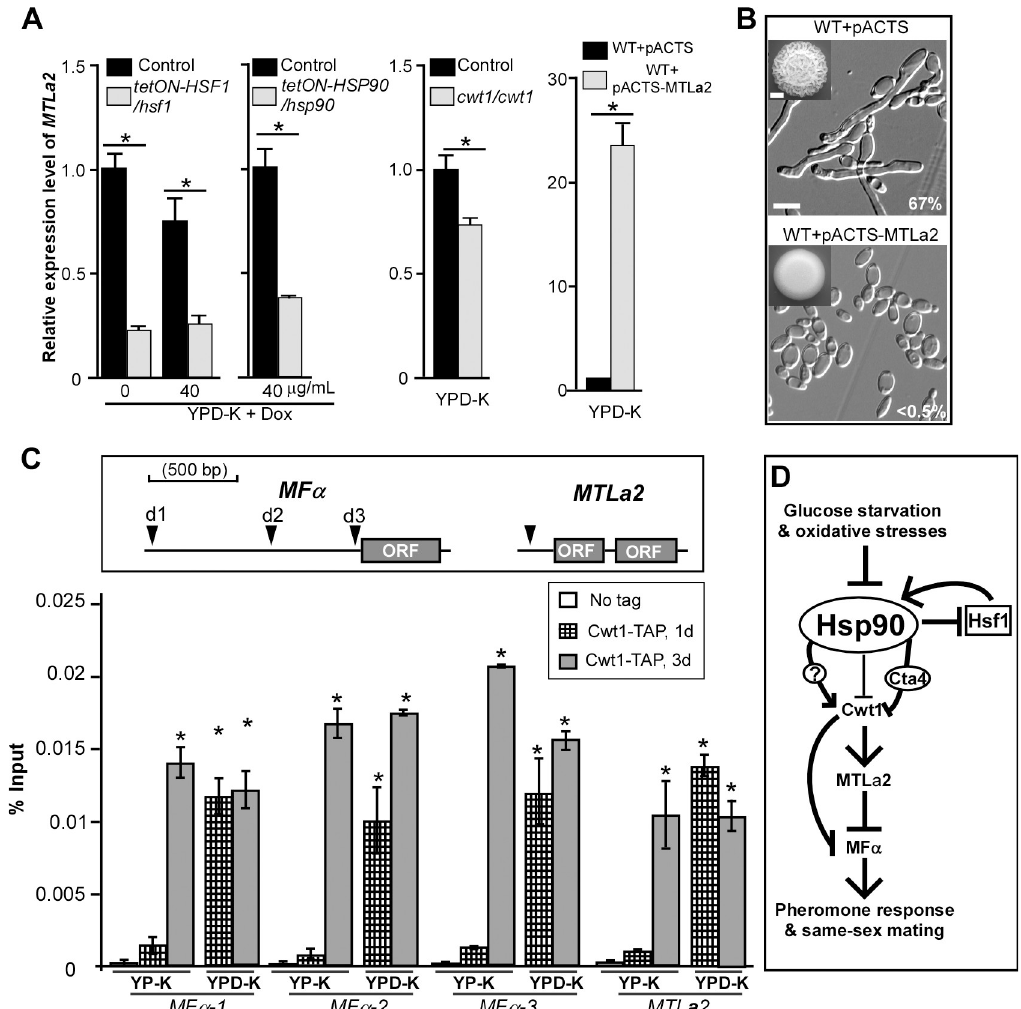
Fig 8. MTLa2 regulates the development of mating projections in C . albicans . (A) Relative expression levels of MTL a 2 in the corresponding controls, tetON-HSF1/hsf1 , tetON-HSP90/hsp90 , and cwt1/cwt1 mutants, and MTL a 2 - overexpressing strain on YPD-K medium. Transcript levels were normalized to ACT1 . Error bars, standard errors of technical duplicates. � p < 0.05, two-tailed Student t test. Experiment was performed in biological replicate, and a representative image is shown. (B) 1 × 10 5 cells of each strain were spotted on YP-K medium and cultured at 25˚C for five days. Morphologies of the control (WT + pACTS) and MTL a 2 -overexpressing strains (WT + pACTS- MTL a 2 )on YP-K medium. WT, GH1350a. Scale bar for colonies, 2 mm (inset); scale bar for cells, 10 μ m. (C) Cwt1 binds to the promoters of MTL a 2 and MF α . ChIP assays were performed in TAP-tagged Cwt1 strains. Percentages of input genomic DNA are indicated. 1 × 10 5 cells of each strain were spotted on YP-K or YPD-K media and cultured at 25˚C for one or three days. Dark arrows indicate detected promoter regions. d1, d2, and d3, three detected sites of MF α . Error bars represent standard error of two technical replicates. � p < 0.05, two-tailed Student t test. Experiment was performed in biological replicate with a representative image shown. The data for the untagged control correspond to samples harvested at day 1. The numerical data are presented in S3 Data . (D) Regulatory model of glucose- starvation–or oxidative-stress–induced same-sex mating in C . albicans . Glucose starvation or oxidative stresses cause the overwhelming of the Hsf1/Hsp90 functional capacity that regulates the transcriptional expression and activity of CWT1 in both direct and indirect manners. Cwt1 regulates same-sex mating through the control of MF α or MTL a 2. ACT1 , ACTin 1; ChIP, chromatin immunoprecipitation; Cta4, Candida TransActivating protein 4; Cwt1, Cell Wall Transcription factor 1; Dox, doxycycline; Hsf1, Heat Shock transcription Factor 1; Hsp90, Heat shock protein 90; MF α , Mating α factor precursor; MTL , Mating type locus; pACTS, plasmid pACTS; TAP, Tandem affinity purification; tetON , tetracycline-induced; tetON-HSF1/hsf1 , tetON -promoter–controlled conditional expression strain of HSF1 ; WT, wild type; YPD-K, yeast extract-peptone-glucose- K 2 HPO 4 ; YP-K, yeast extract-peptone-K 2 HPO 4